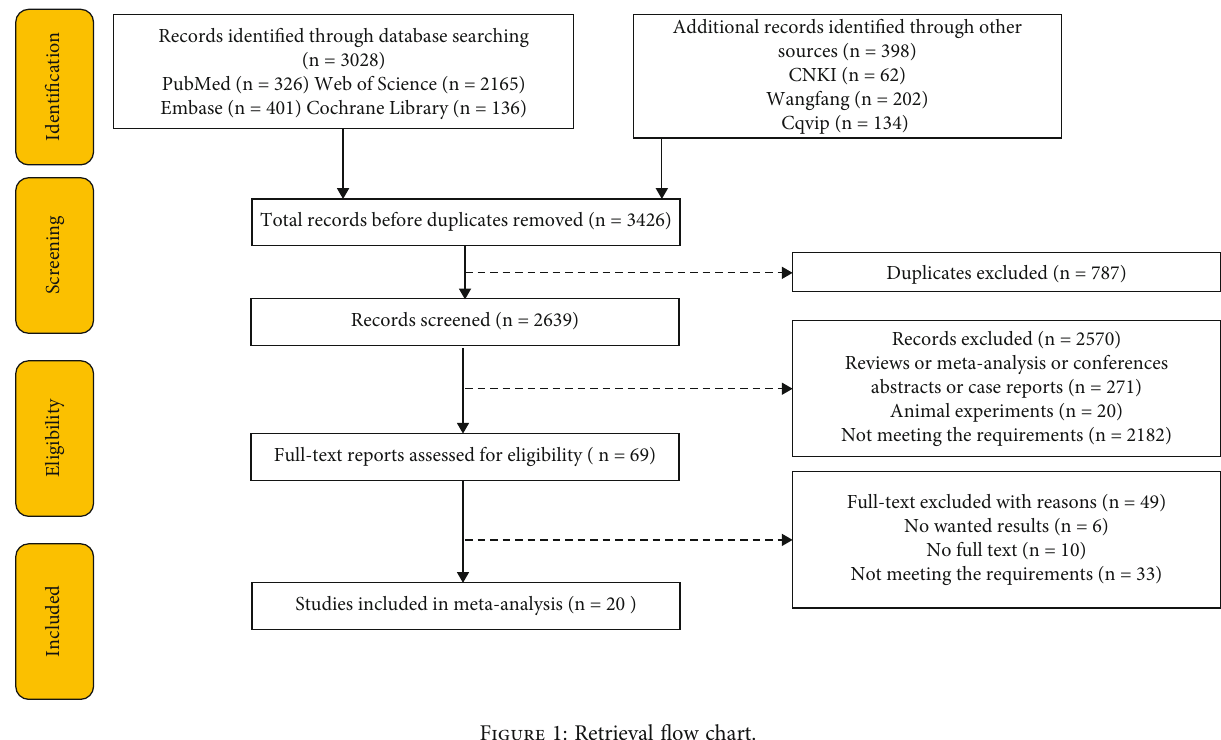
Figure 1: Retrieval fl ow chart. Table 1: Baseline